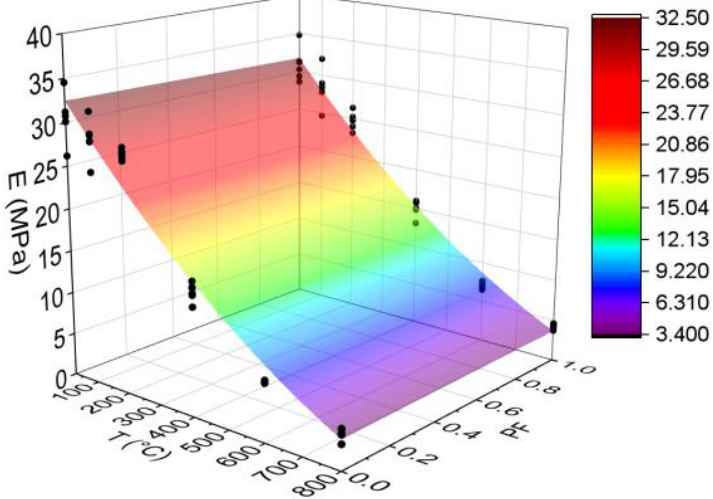
Figure 9. Quadratic multiple regression model fitting for elastic modulus estimation.